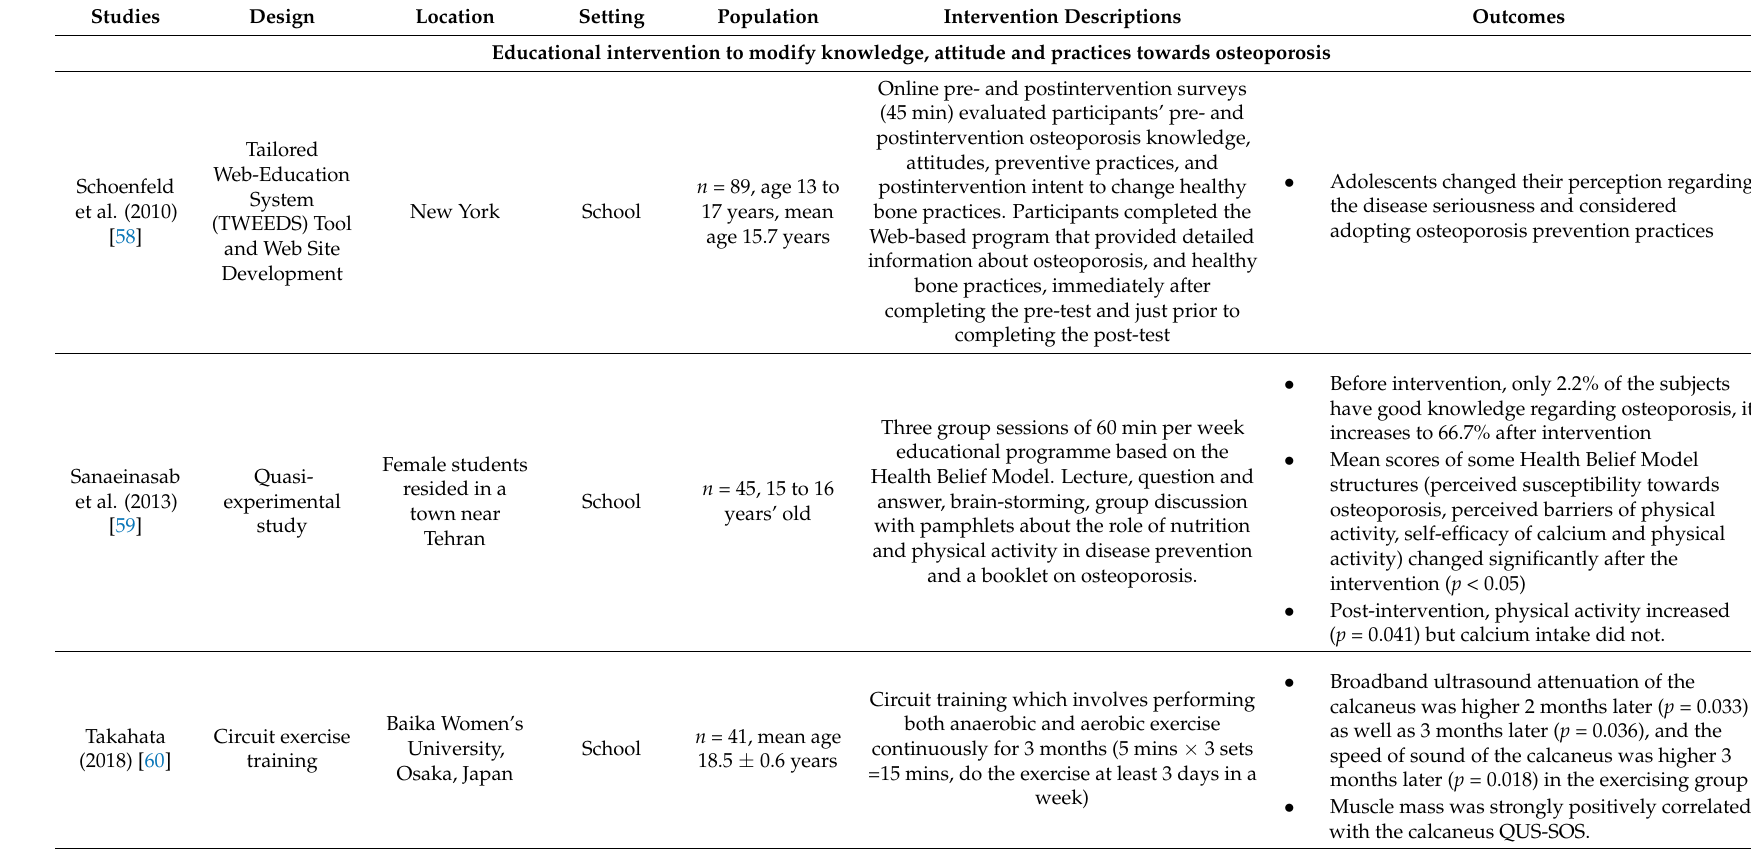
Table 5. Education approaches to improve knowledge, beliefs or practice of adolescents and young adults regarding